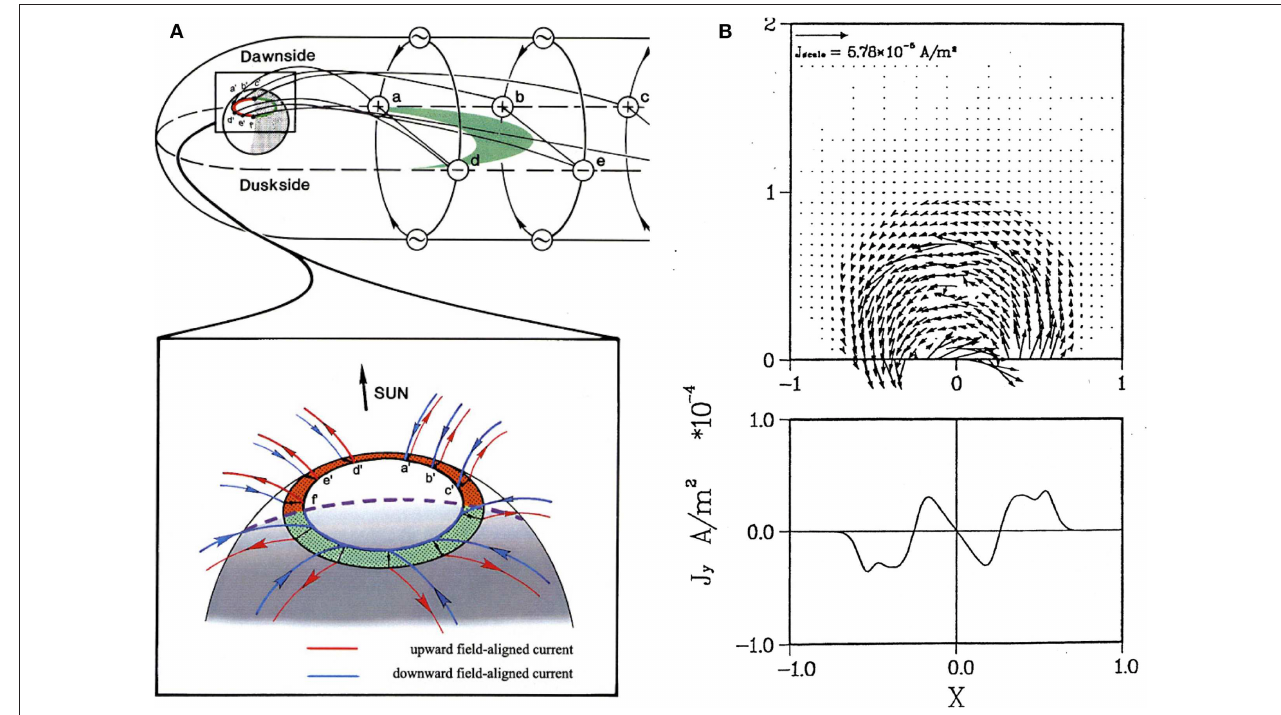
FIGURE 3 | The electric current system generated directly by the dynamo. (A) In the magnetosphere, there are two current systems, one is the two half- solenoidal currents, and the other is the field-aligned current system, connecting the dynamo terminals and the auroral oval (Akasofu). (B) In the solar atmosphere, one of the currents flows along the magnetic field lines of the magnetic arcade; the current intensity is also shown. The photospheric dynamo generates another current system, which is discussed in sections Power Accumulation and Energy Unloading (Release) (Courtesy of G. S.